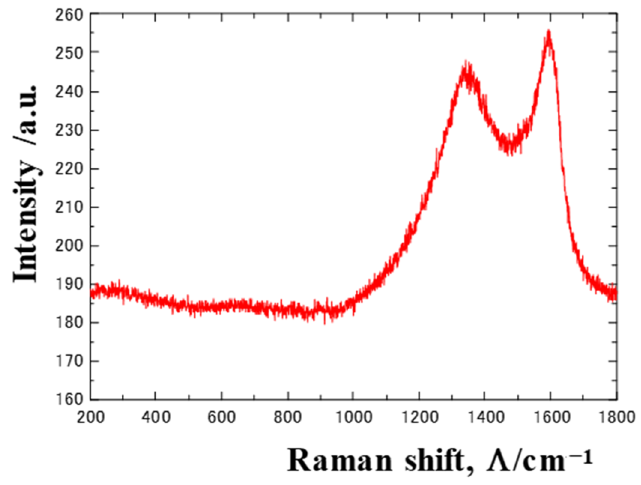
Figure 15. Raman spectrum at the center of contact interface between the Cs-SKD11 punch and the pure titanium work after continuously forging 20 times down to 50% in the reduction in thickness.